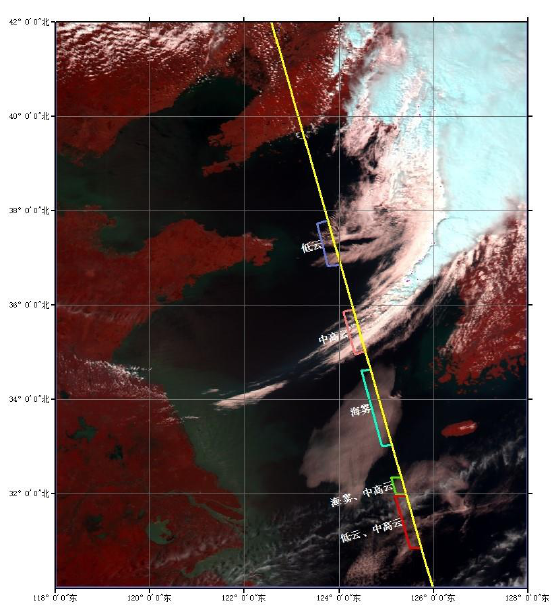
Figure 4. May 13, 2017 MODIS RGB Images